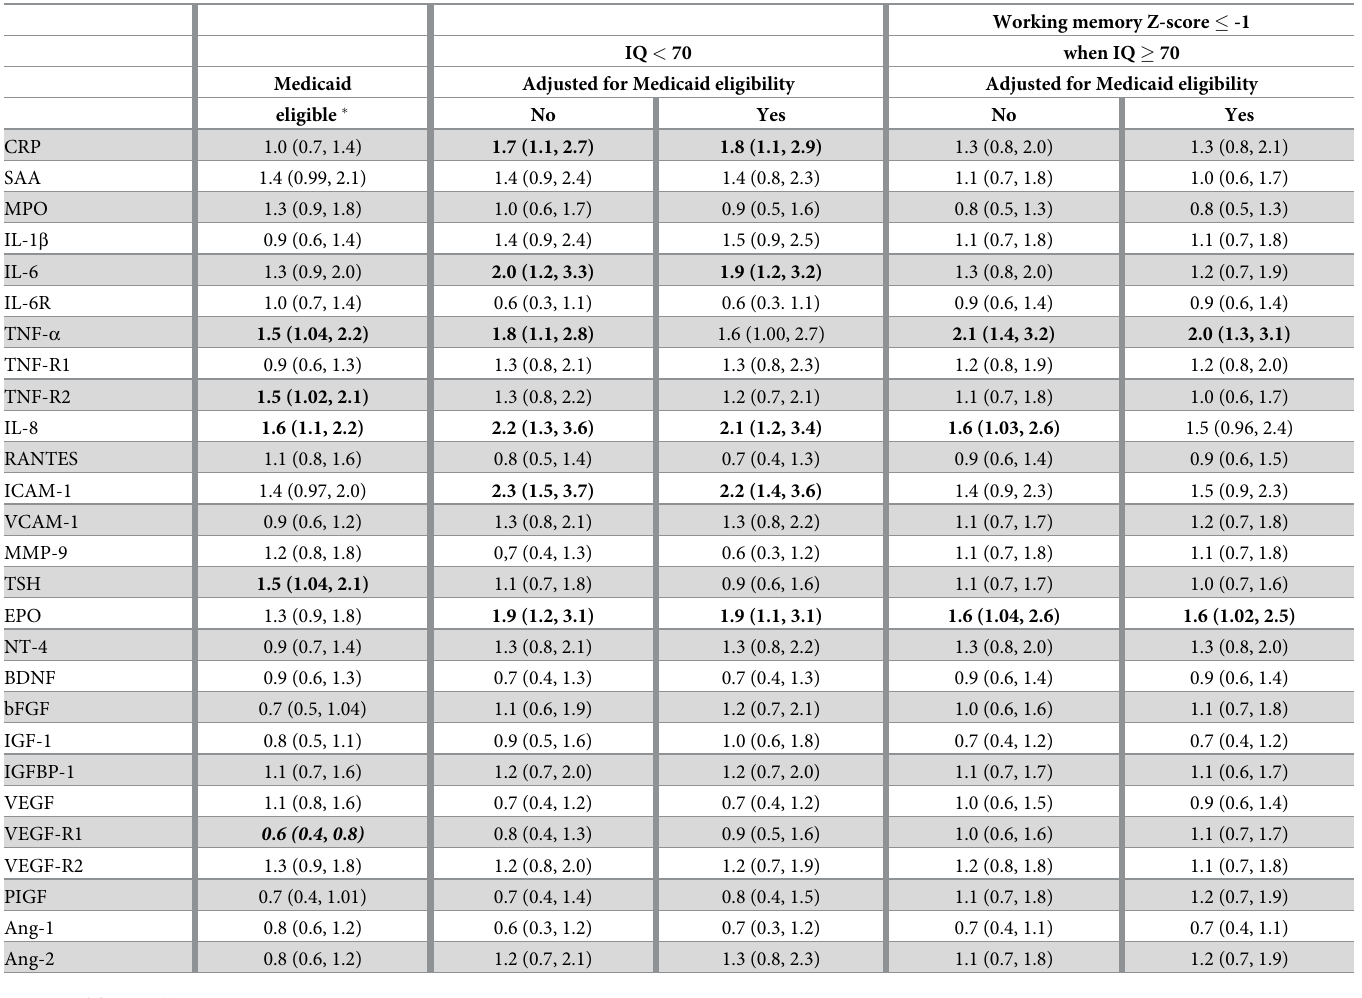
Table 4. Odds ratios (95% confidence intervals) for the 10-year old having an IQ less than 70, and separately, among children whose IQ � 70, having a working memory more than one standard deviation below the expected mean associated with a top-quartile concentration of the protein listed on the left on 2 days during the early epoch. In one set of analyses adjustment is made for mother’s Medicaid eligibility at the time of delivery, while in another, such adjustment is not made although in both situations adjustment is made for gestational age category and birth weight Z-score < -1. Bold indicates odds ratios significantly > 1 (p < 0.05) and bold italic indi- cates odds ratios significantly < 1 (p <